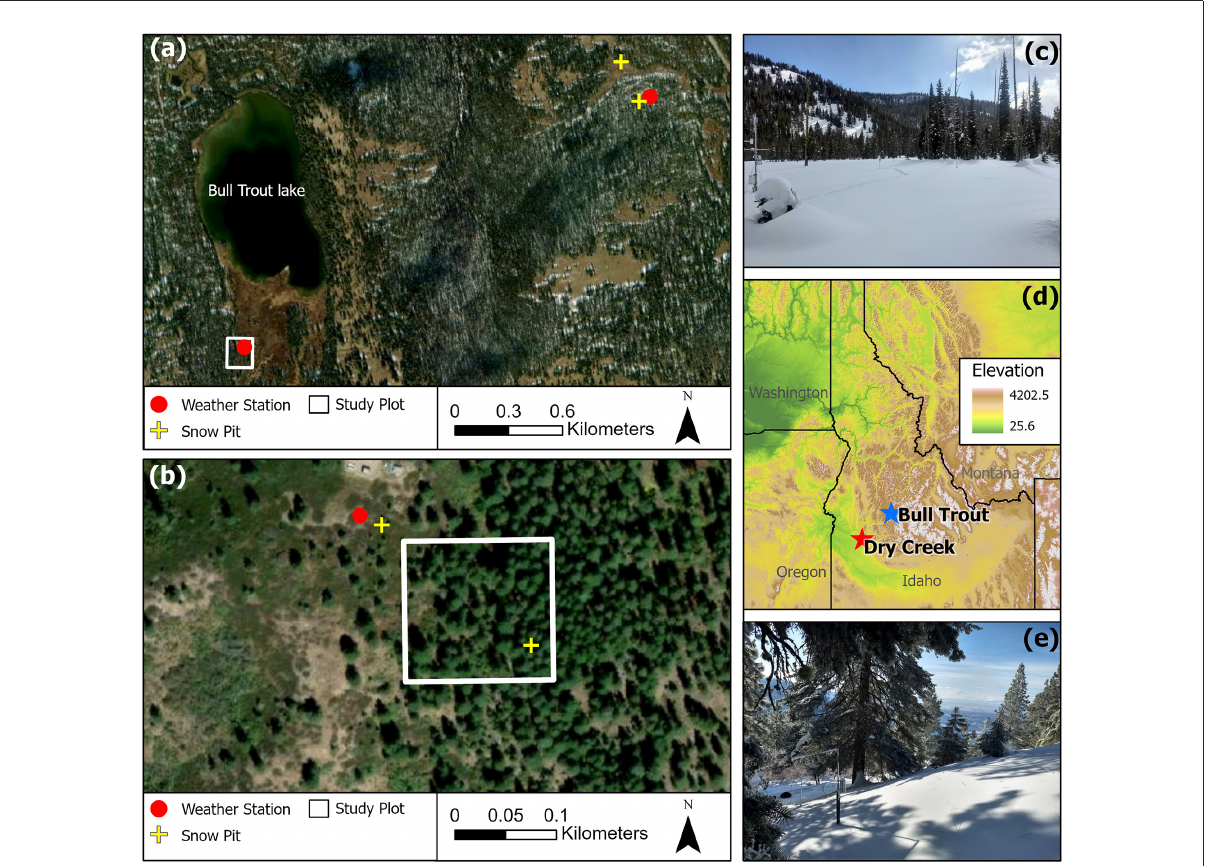
FIGURE1 Locations with aerial images (ESRI, 2017) of the Bull Trout (a) and Dry Creek (b) study location in southern Idaho, overview location of the two study sites (d) and pictures of the BT study location looking south east toward the open site (see Figure 2a) (c) and LDP study location looking south toward the sparse vegetation snow depth sensor (see Figure 2b) (e) . The white squares represent the location of the snow depth sensor array and radiometer array (LDP only). The red dots are weather station locations, and the yellow crosses are SnowEx snow pit